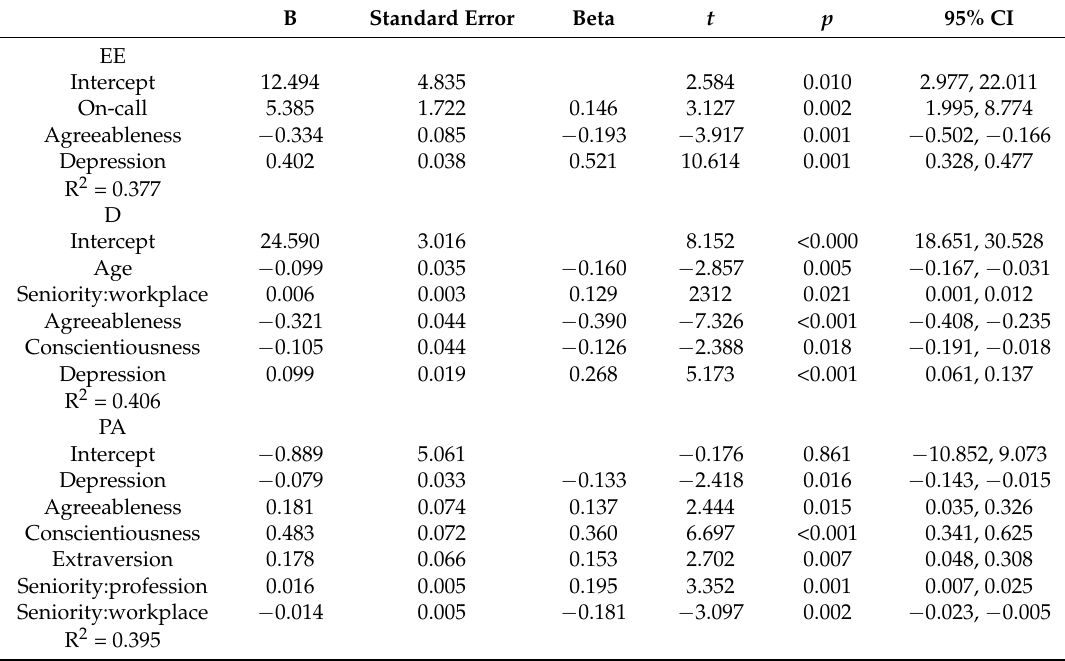
Table 5. Multiple linear